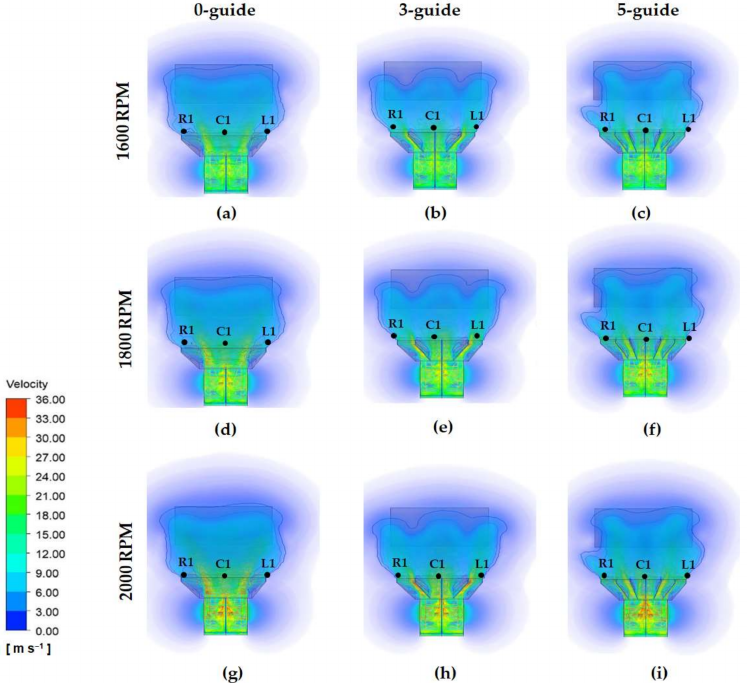
Figure 9. Shape analysis of flow field for foreign materials separating part of xy plane on conditions of 0-guide ( a ), 3-guide ( b ), 5-guide ( c ) at 1600 RPM, 0-guide ( d ), 3-guide ( e ), 5-guide ( f ) at 1800 RPM, and 0-guide ( g ), 3-guide ( h ), 5-guide ( i ) at 2000